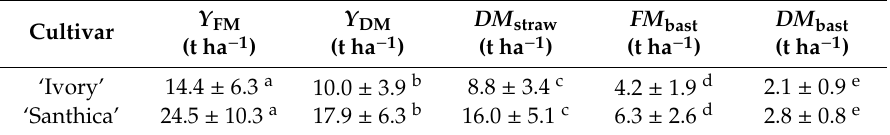
Table 1. Fresh mass-( Y FM ) and dry mass ( Y DM )-based yields per production area and yearly means of total fresh mass ( FM plant ), and straw dry mass ( DM straw ) as well as bast fresh ( FM bast ) and dry mass ( DM bast ) produced by ‘Ivory’ and ‘Santhica 27’ plants (t ha − 1 ) on the experimental area. Same superscripts indicated insignificant di ff erences between means of the respective